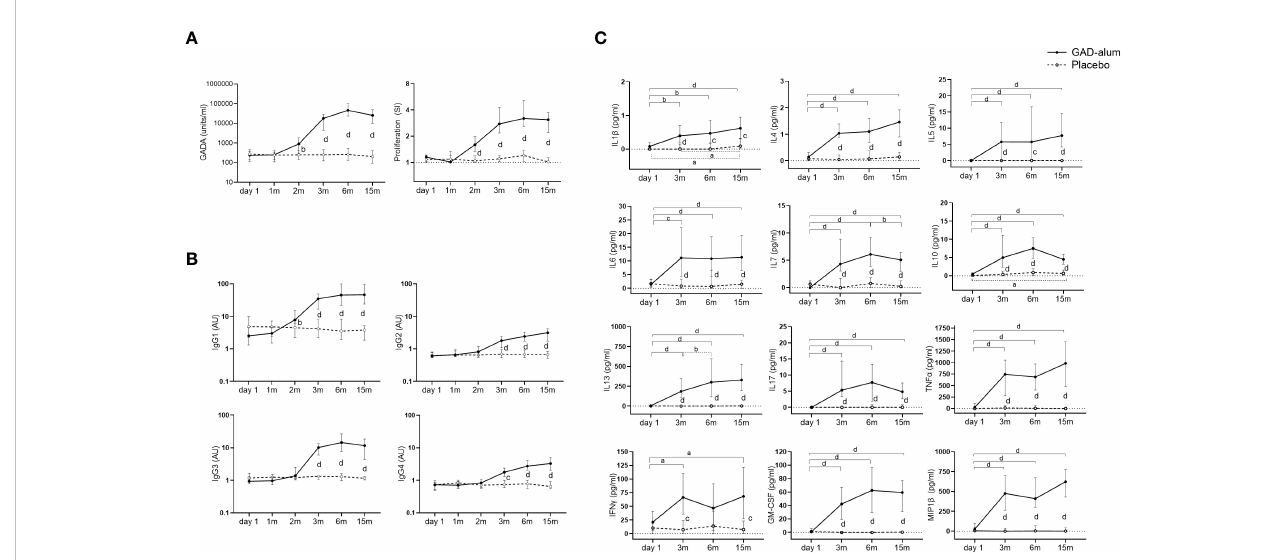
FIGURE 1 Immune response from day 1 to 15 months in GAD-alum (smooth line, n=56) and Placebo (dashed line, n=52) individuals. (A) Median values of GADA (U/ ml) and PBMCs proliferative response to GAD 65 (5 µg/ml). Proliferation is expressed as stimulation index (SI), calculated from the mean of triplicates in the presence of GAD 65 divided by the mean of triplicates with medium alone. (B) Median levels of IgG1, IgG2, IgG3, and IgG4 GADA subclasses, shown as arbitrary units (AUs). (C) Cytokine secretion detected by Luminex in PBMCs supernatants after 7-days culture in presence of GAD 65 (5 µg/ml). Median levels of GAD 65 -induced IL1 b , IL4, IL5, IL6, IL7, IL10, IL13, IL17, TNF a , IFN g , GM-CSF and MIP-1 b are given after the subtraction of the spontaneous secretion from each individual, and expressed as pg/ml. Horizontal lines represent the median, and error bars indicate 95% CI. Differences within the same group were calculated using Wilcoxon paired test, and differences between groups were calculated using Mann-Whitney unpaired test. a, b, c, d: p<0.05, p<0.01, p<0.001,